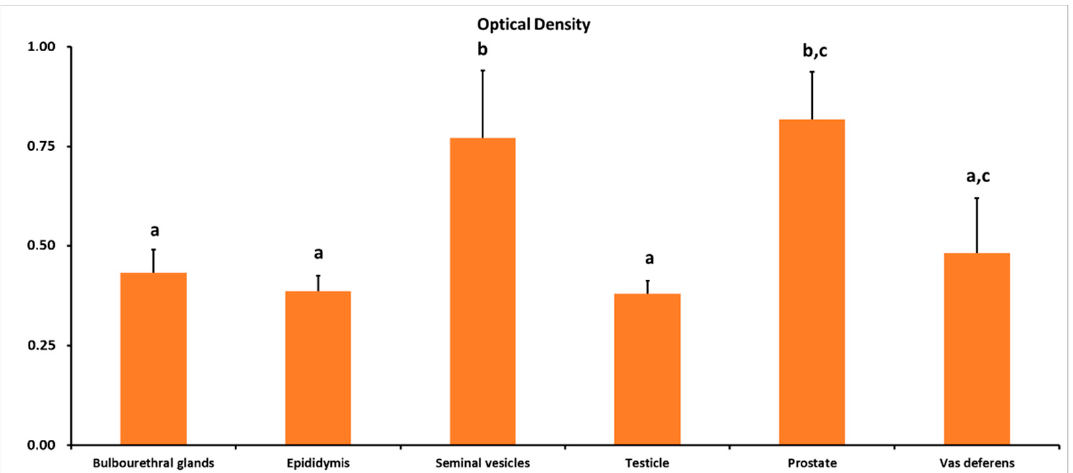
Figure 2. Immunoreaction intensity of ADIPOR1, performed on adult ram male reproductive tis- sues. Different letters above bars indicate significantly different values (ANOVA p < 0.001, Levene’s test p > 0.05).